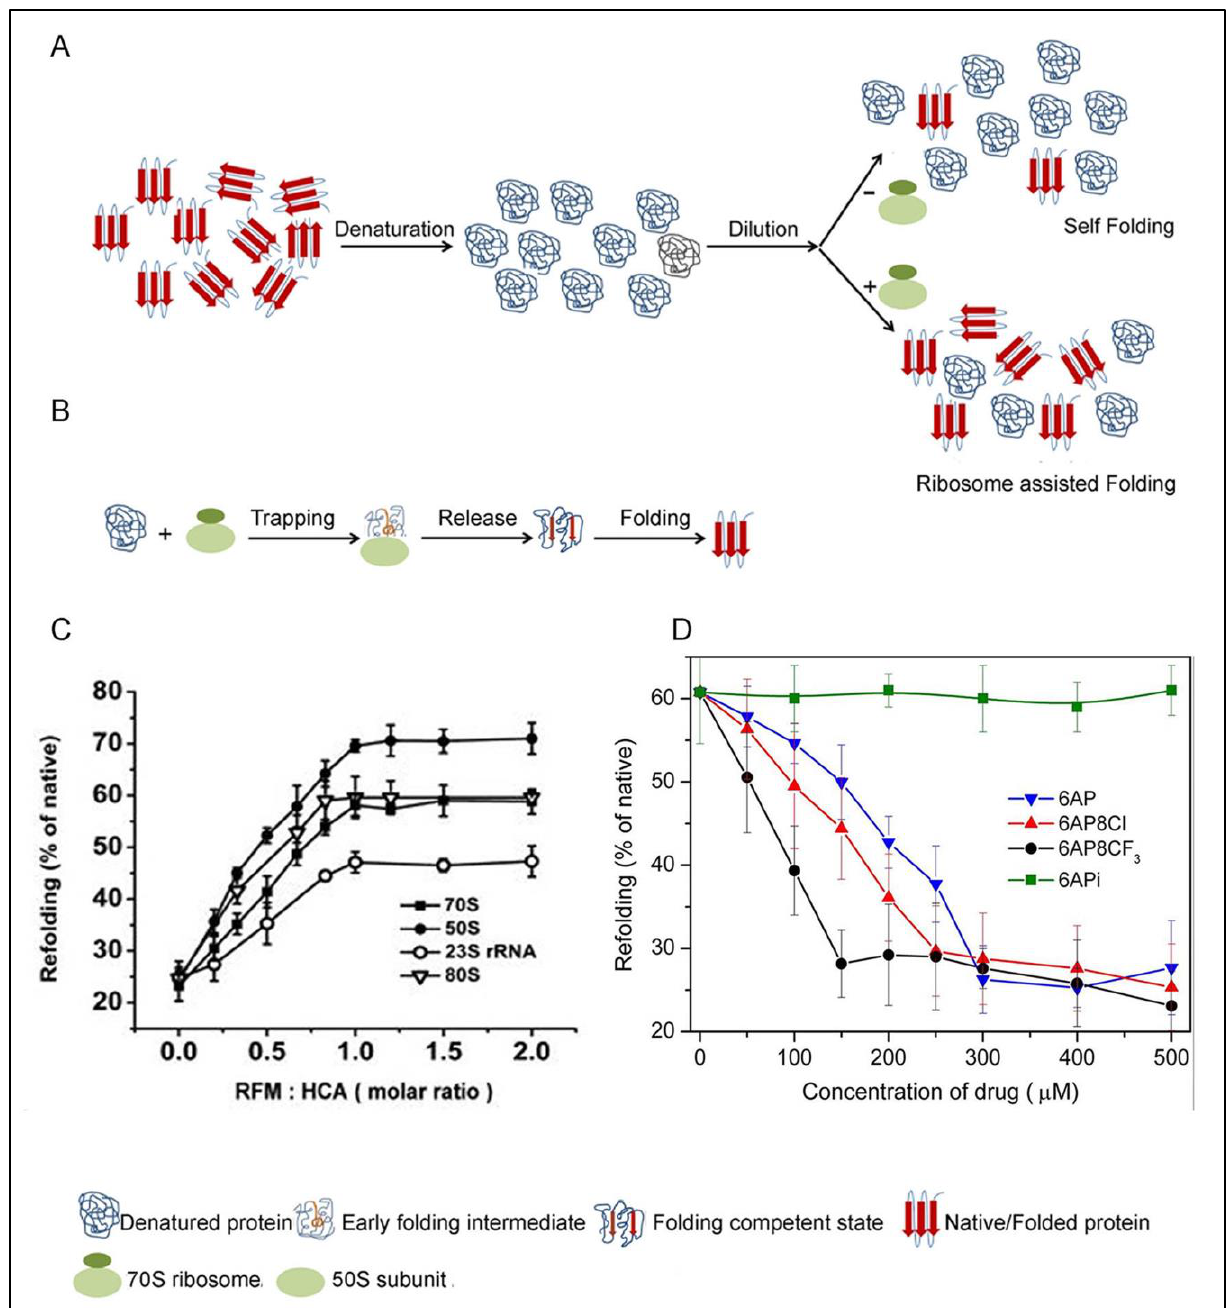
Figure 3. ( A ) Scheme of PFAR (Protein Folding Activity of the Ribosome) assay; self-folding and ribosome assisted folding; ( B ) Two step trapping and release model of PFAR; ( C ) Refolding of HCA with different RFMs and at various RFM: HCA ratios (Reproduced with permission from [44]. Copyright © 2011 Elsevier Masson SAS. All rights reserved), (D) Inhibition of PFAR by 6AP derivatives using HCA as the model protein. (Reproduced with permission from [45]. Copyright © 2014 Elsevier Masson SAS. All rights